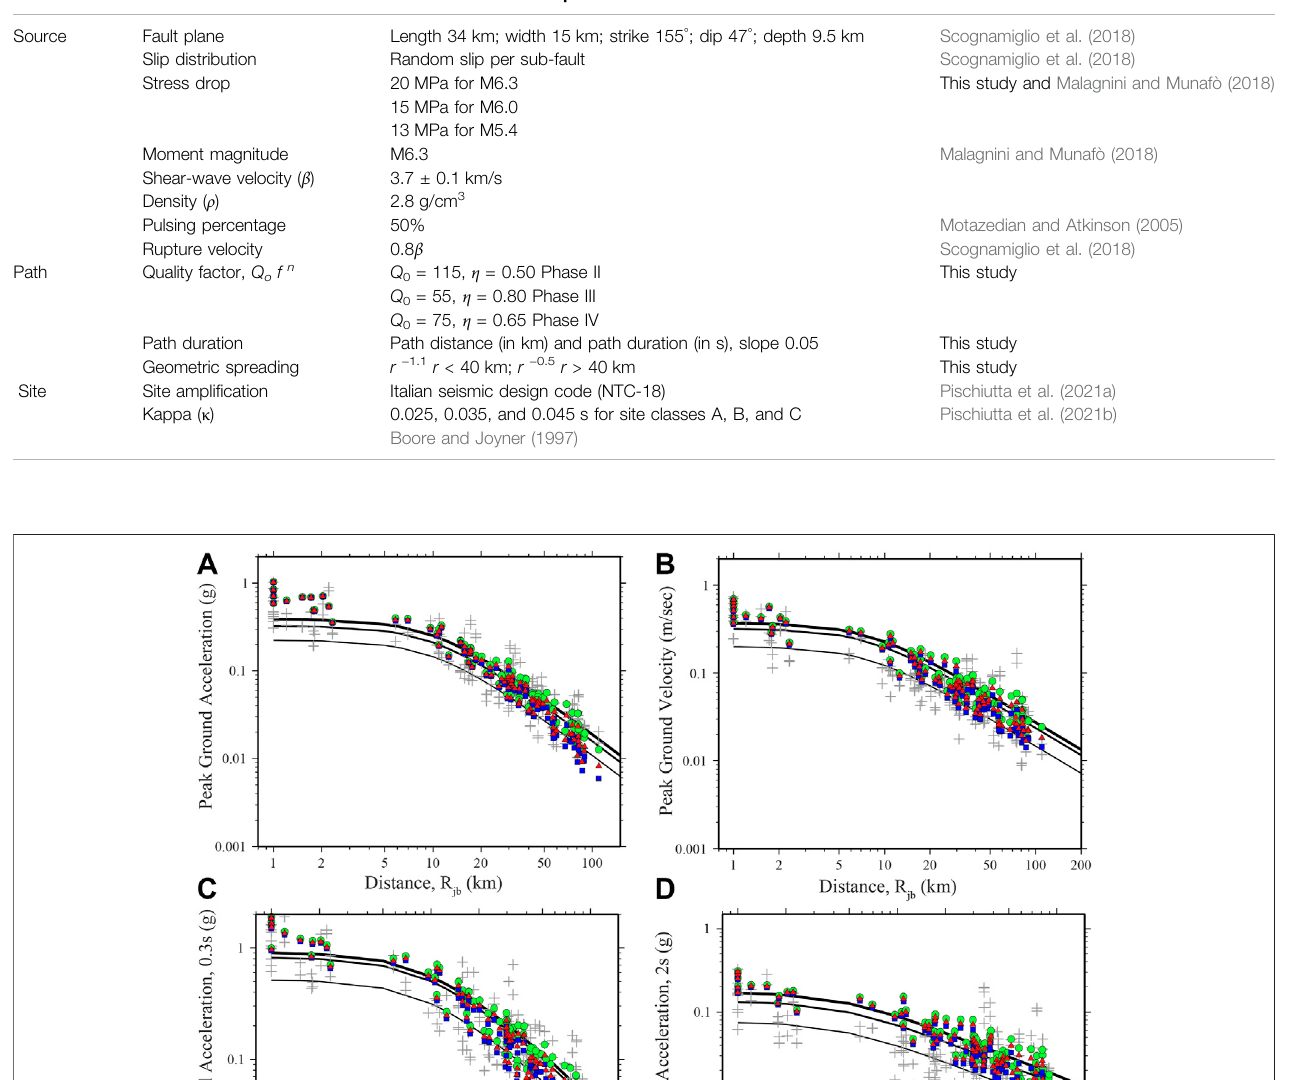
0.025 compared to those estimated from the Amatrice (green circles) and Norcia (red triangles) sequence attenuation functions, both being less frequency-dependent, Q( f ) = 115 ±